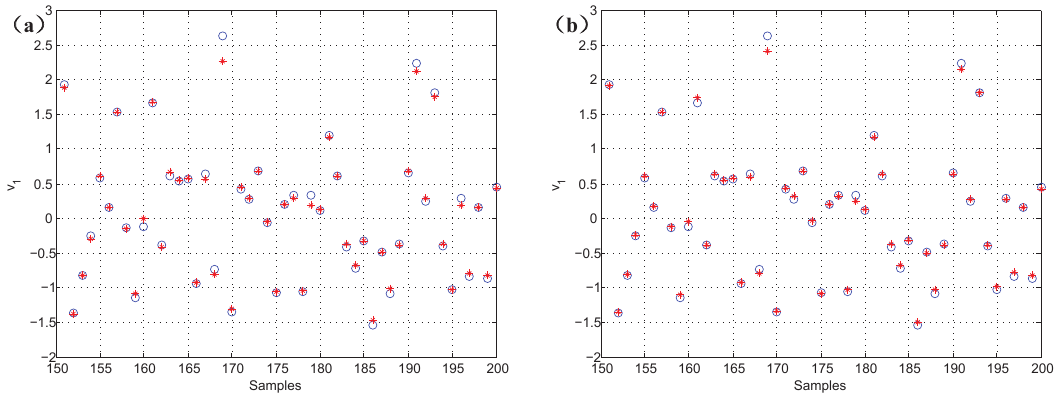
Figure 5. The comparison of reconstructed data and original data; “*” represents reconstructed data, and “o” represents original data. ( a ) k-NN; ( b )